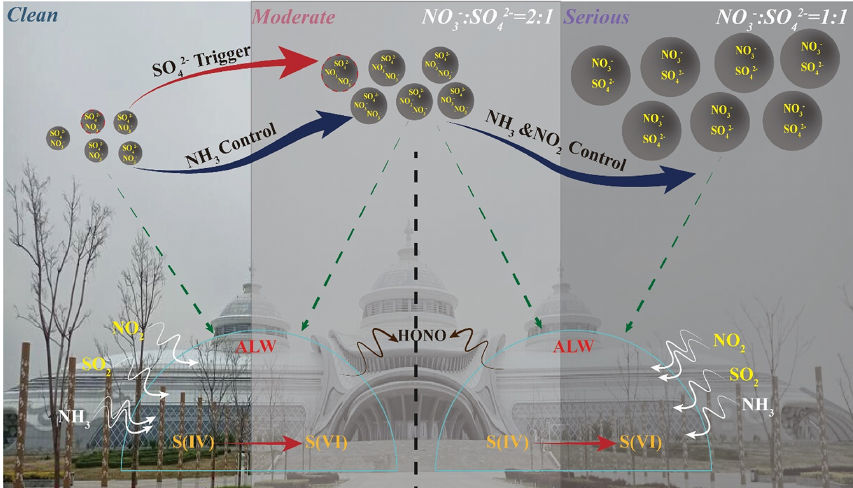
Figure 6. The characteristics and formation mechanisms of SIAs during haze aggravation.